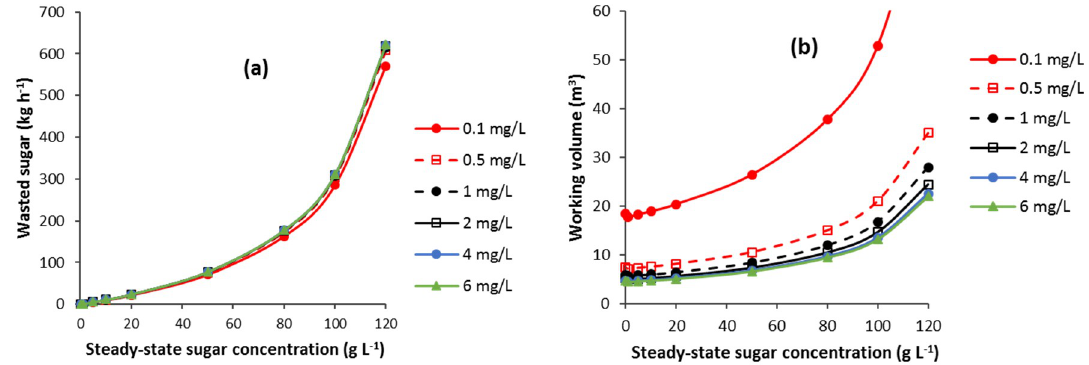
Figure 3. E ff ect of CSTB steady-state oxygen concentration on ( a ) wasted substrate and ( b ) bioreactor working volume.